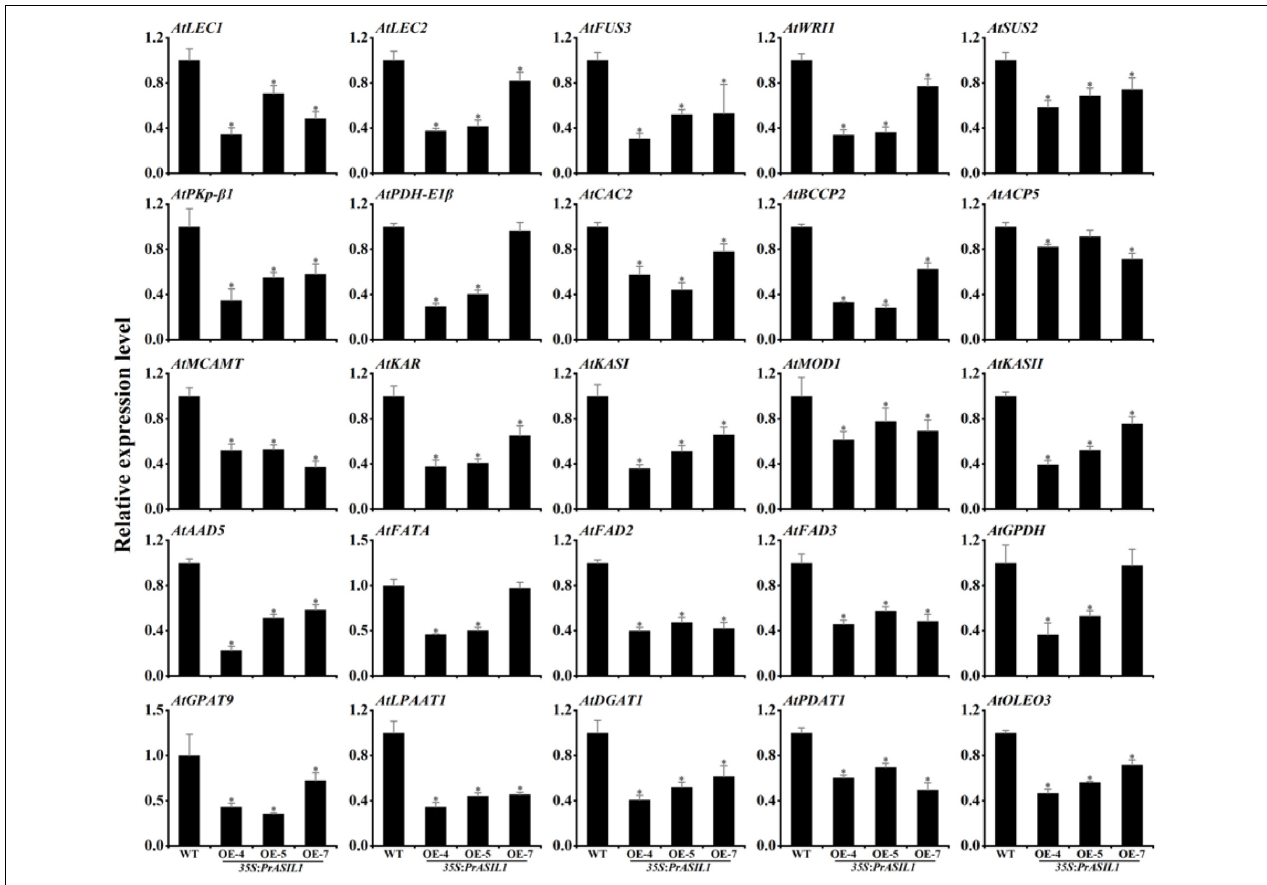
FIGURE 6 | Comparison of the expression levels of genes involved in FA biosynthesis, modification, and TAG accumulation between the seed of wild type (Col-0) and PrASIL1 transgenic plants. Results were normalized to the expression of AtACTIN7 and calibrated to the levels of wild type. Values are mean ± SD ( n = 3). Asterisks indicate significant differences in the expression levels compared to that in the wild type (two-tailed paired Student’s t -test, P < 0.05).